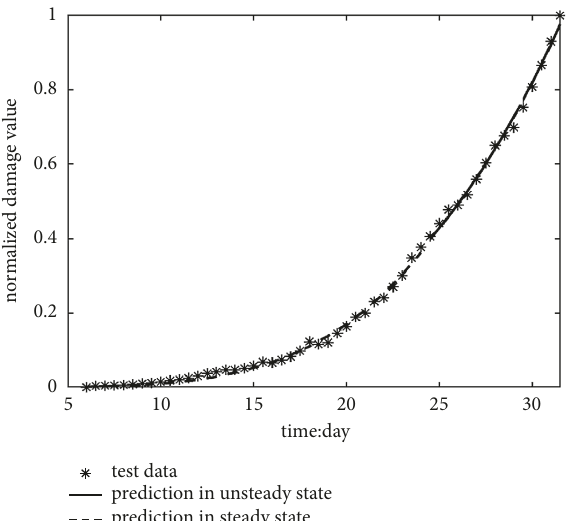
Figure 11: The comparison of the remaining useful life calculated in two